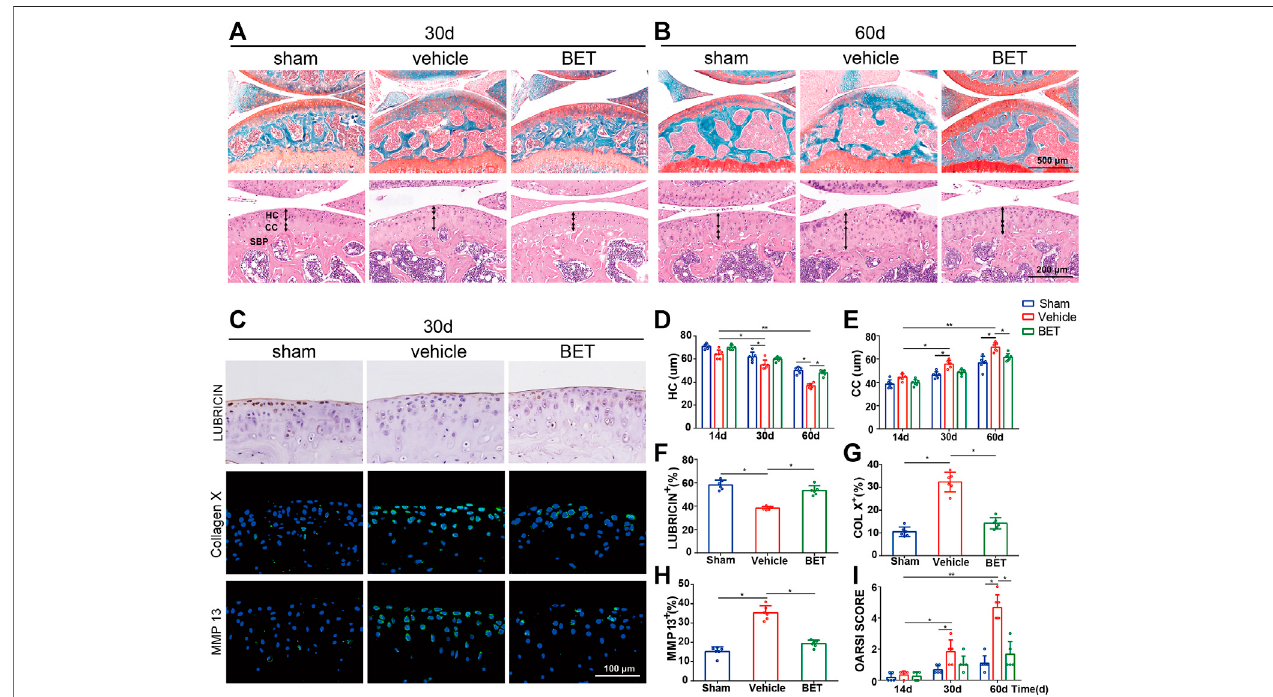
FIGURE 3 | Betaine attenuates cartilage degeneration in OA mice. (A,B) Safranin O and fast green staining (top) showed proteoglycan loss and cartilage damage 30and 60 days after operation. Scalebar,500 μ m. Double-headedarrows marked hyaline cartilage(HC) and calci fi ed cartilage(CC) thickness inH&E staining(bottom). Scalebars,200 μ m. (C) Immunostainingoflubricin (upper),COLX(middle)andmatrixmetalloproteinase(MMP)13(lower)inarticularcartilageofkeenjoint30 daysafter surgery.Scalebar,100 μ m. (D,E) ChangesoftheHCandCCthicknessesineachgroupandtimepoint. (F – H) Quantitativeanalysisoflubricin,COLXandMMP13 expression in cartilage 30 days after surgery. (I) OA Score of articular cartilage degradation in each group and time point. * p < 0.05 as denoted by bar, ** p < 0.01 as denoted by bar.